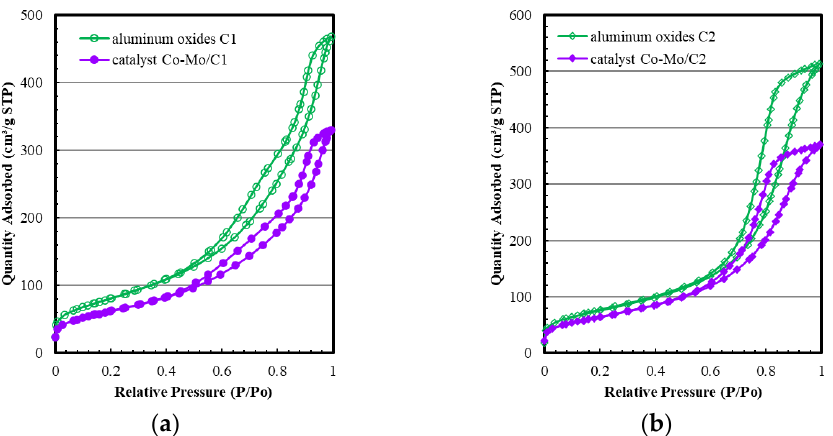
Figure 4. ( a ) Nitrogen adsorption–desorption isotherms for aluminum oxides C1 and catalysts. ( b ) Nitrogen adsorption–desorption isotherms for aluminum oxides C2 and